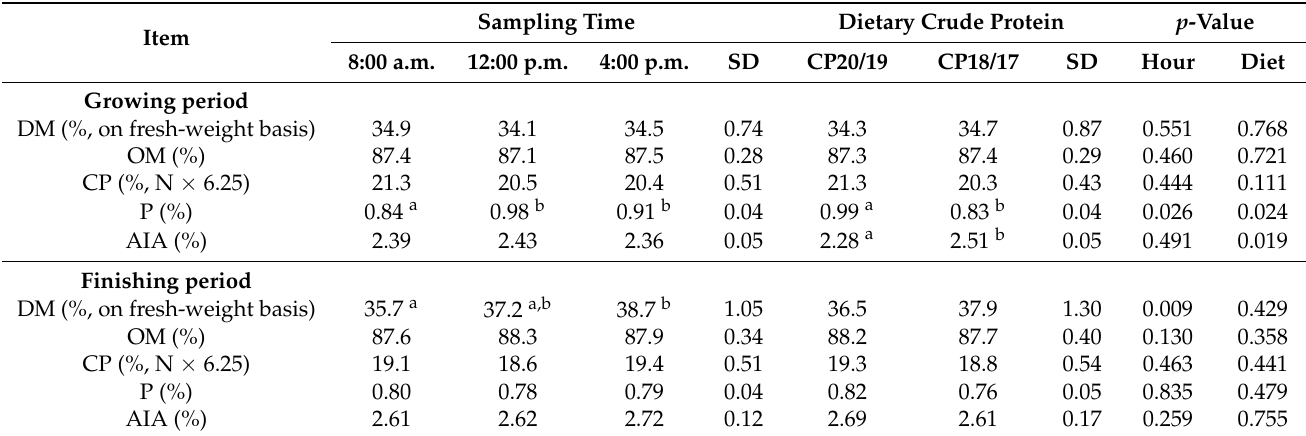
Table 2. Faecal composition in the growing and finishing